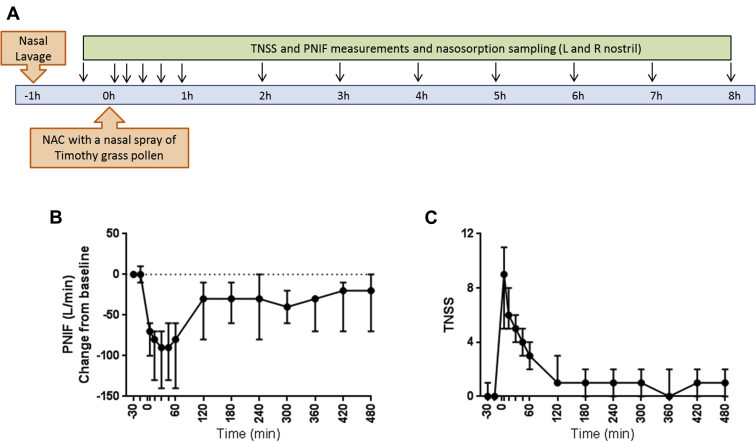
Study design and clinical response. A, Clinical events during NAC. Nasal lavage was performed before allergen administration. Nasosorption sampling and measurements for total nasal symptom score (TNSS) and peak nasal inspiratory flow (PNIF) were taken at 5, 15, 30, 45, and 60 minutes post-NAC, then hourly to 480 minutes. Clinical severity of the allergic reaction was measured by (B) PNIF and (C) TNSS at each time point. N = 15. L, Left; R, right. Data are represented as medians with interquartile ranges.